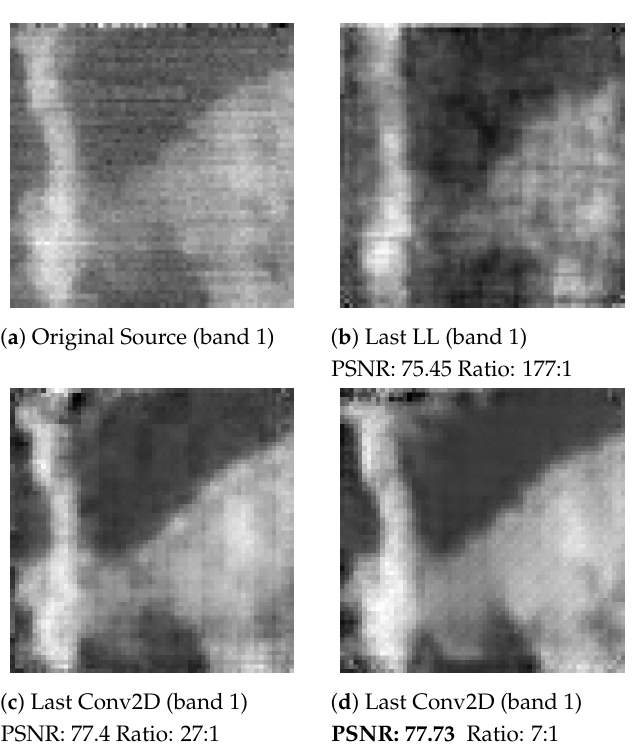
Figure 6. Visual comparison (VIRTIS-Rosetta dataset) using the compression ratio of 27:1 and data type 16 bits of the original source tile 432 × 64 × 64 × 32 bits (only bands 1, 2, 3, and 432 are shown) with the relative hyperspectral cube reconstructed by SSCNet from 1024 × 8 × 8 × 32 data information, using an initial preprocessing for the band normalization (max/min) to obtain a fast learning convergence.